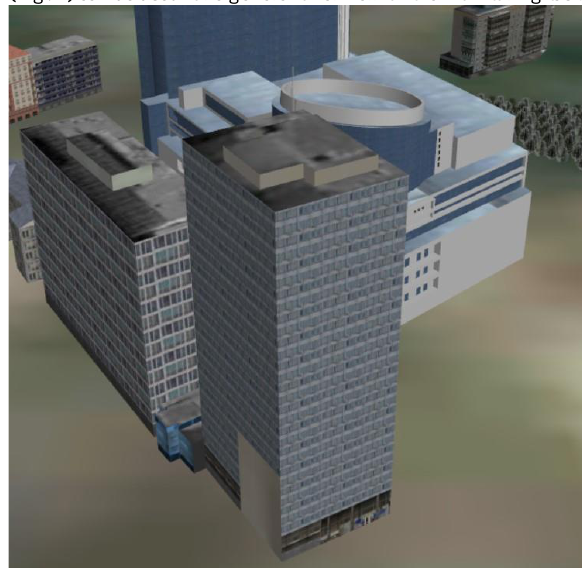
Figure 4 . Architectural model.